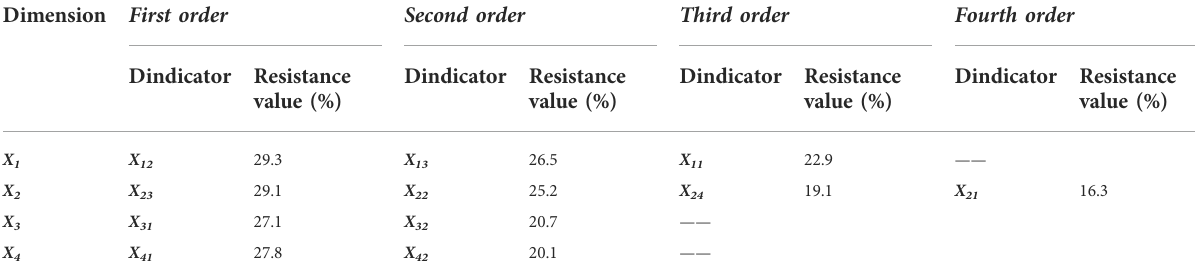
Note: Resistance value is percentage.